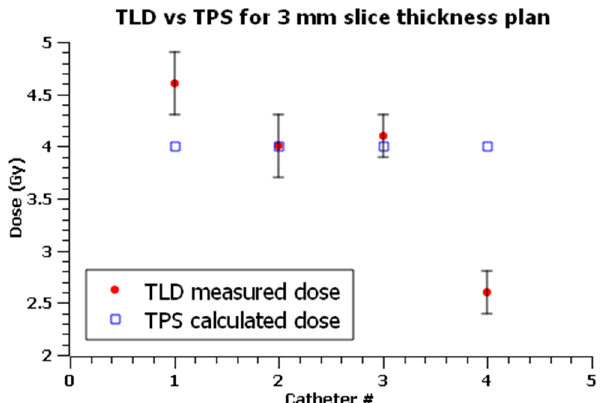
Figure 10. Comparisons between TLD measured doses (in red full dots) and TPS calculated doses (in blue empty squares) for the 3 mm slice thickness plan. x axis is the catheter number (#) corresponding to the point of measurement. Error bars show the estimated expanded (k = 2) uncertainty for TLD measurements.